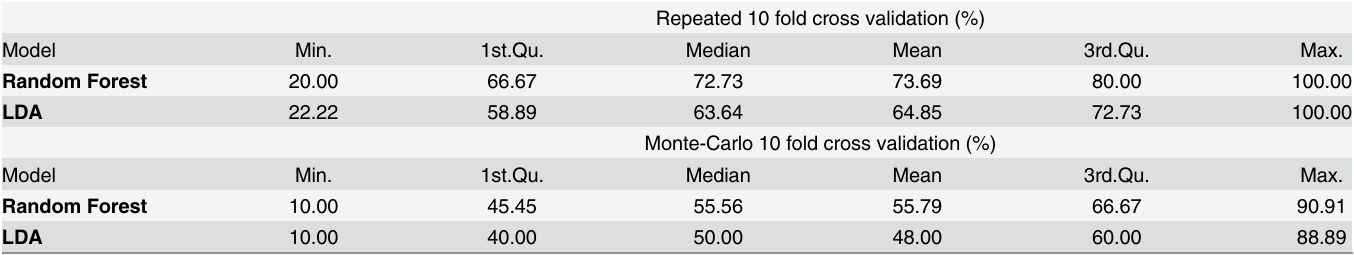
Table 7. Accuracy results of repeated 10 fold cross validation of the Random Forest and Linear Discriminant Analysis (LDA) models built to clas- sify patients with prostate cancer and cancer-free controls based on blood PSA levels and urinary VOCs.